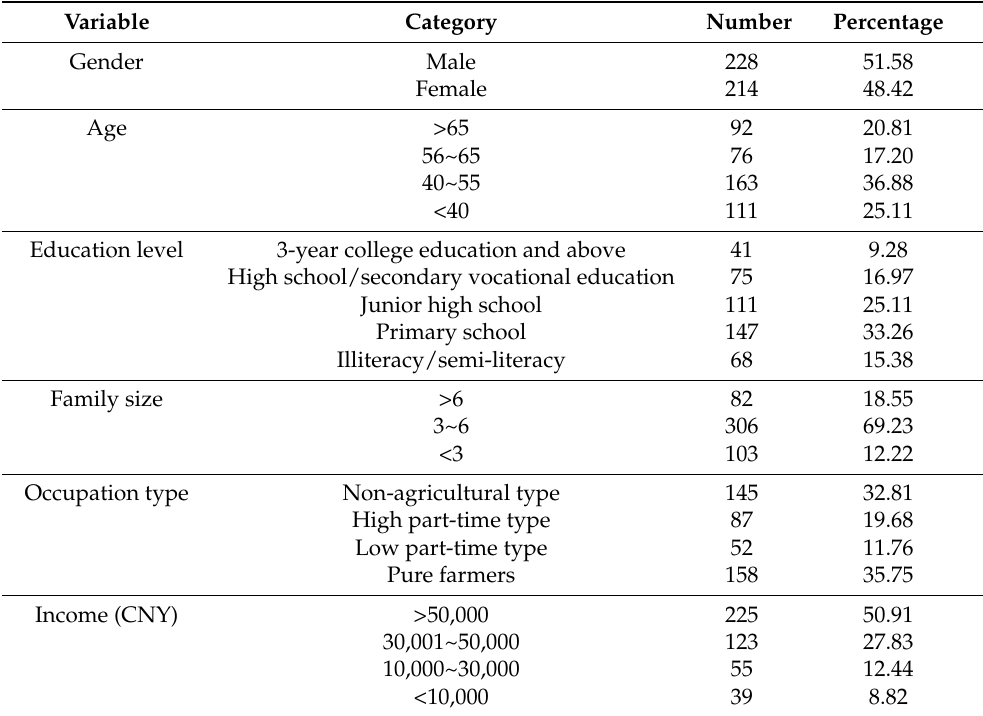
Table 1. Basic characteristics of respondents.